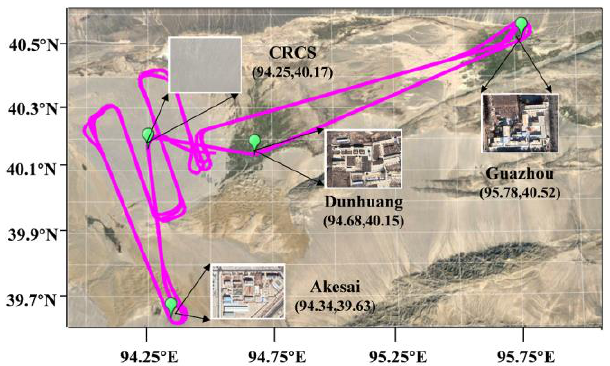
Table 1. Layout of the ground stations.